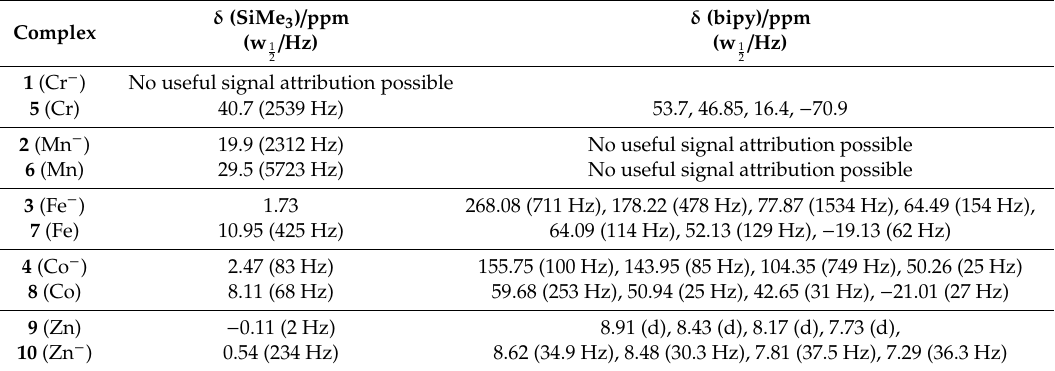
Table 3. 1 H-NMR spectroscopic features of the compounds 1 – 10 in THF-d 8 (500